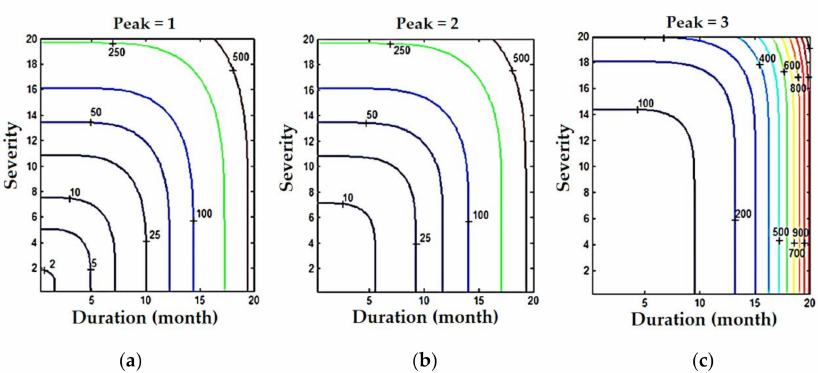
Figure 10. T ∧ curves for di ff erent values of severity peaks based on one-month TSI for the Rasht DSP Basin: 1 ( a ); 2 ( b ); and 3 ( c ).